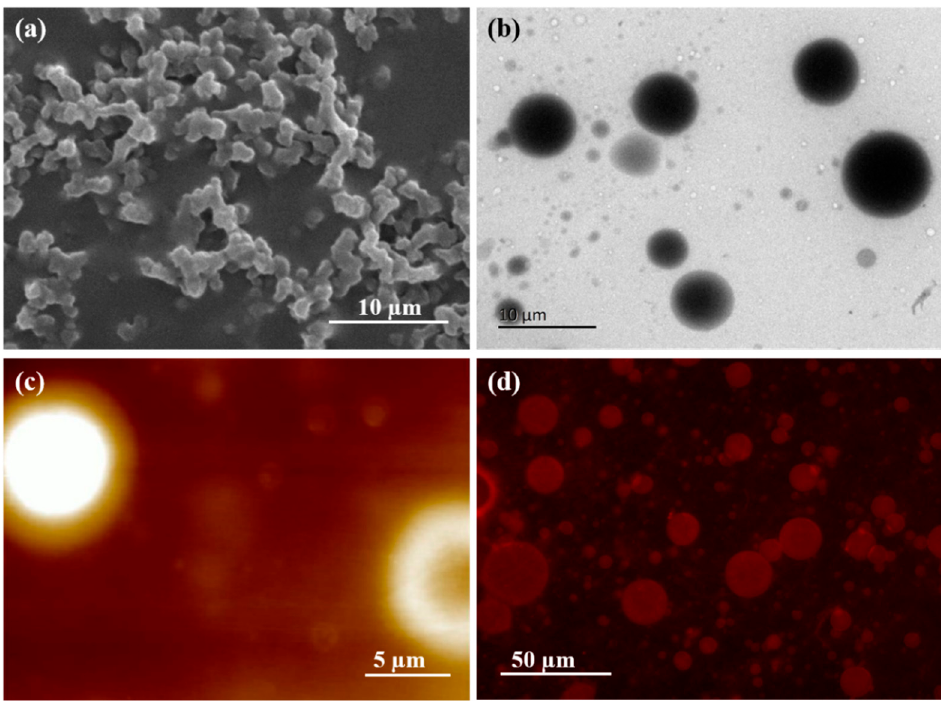
Figure 9. ( a ) SEM, ( b ) TEM, ( c ) AFM and ( d ) Fluorescent images of the drug-loaded RAOA micro- capsules. Table 1. Encapsulation efficiency (EE) and fitting results of release data from the Korsmeyer–Peppas model. Formulation EE a K (min − n ) n R 2 Mechanism SA Aggregates 51.7 ± 4.9% 0.9105 RAOA Microcapsules 87.6 ± 2.8% 0.7876 0.9337